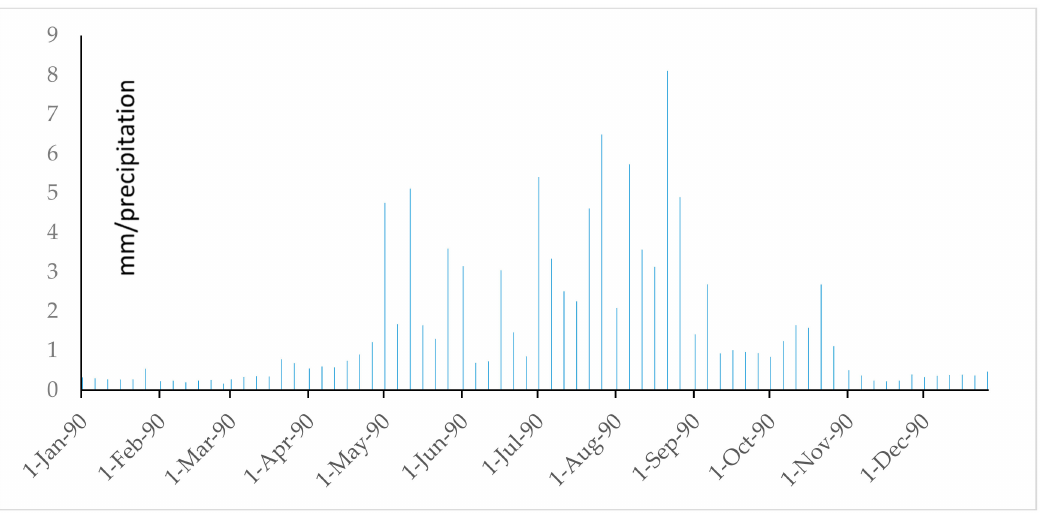
Figure A18. Precipitation of Denko County in